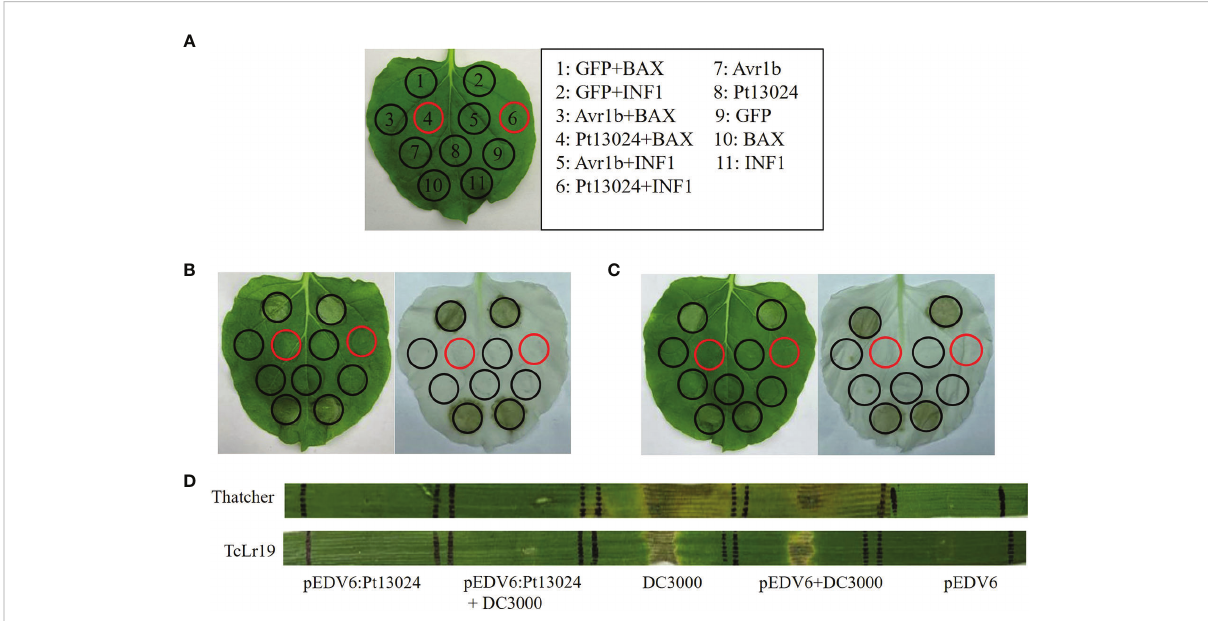
FIGURE 4 Pt13024 inhibited PCD induced by BAX, INF1, and DC3000. (A) The in fi ltration pattern of the treatments. (B) The Agrobacterium GV3101 carrying PVX : Pt13024, PVX:eGFP, and PVX : Avr1b were in fi ltrated in N. benthamiana , after 24 hours Agrobacterium carrying PVX : BAX or PVX : INF1 were in fi ltrated on the corresponding positions, respectively. There is no cell death induced by BAX and INF1 24 h after in fi ltrating with Agrobacterium carrying PVX : Pt13024. On the right side is the decolorized phenotype. (C) The N. benthamiana was in fi ltrated with 1 : 1 (v/v) mixture of Agrobacterium carrying PVX : Pt13024/PVX : GFP/PVX : Avr1b and PVX : BAX/PVX : INF1, respectively. Pt13024 is responsible for the suppression of PCD induced by BAX and INF1. On the right side is the decolorized phenotype. (D) Pt13024 delivered via P. fl ourescens EtHAn into leaves of 10- to 14-day- old seedlings of Thatcher and TcLr19, respectively, and suppressed the HR triggered by P. syringae pv. syringae DC3000. Thatcher and TcLr19 were in fi ltrated. pEDV6 served as control for co-in fi ltration experiments. Photographs were taken 3 days after in fi ltration. BAX, Bcl-2-associated X protein; HR, hypersensitive reaction; PCD, programmed cell death; PVX, potato virus